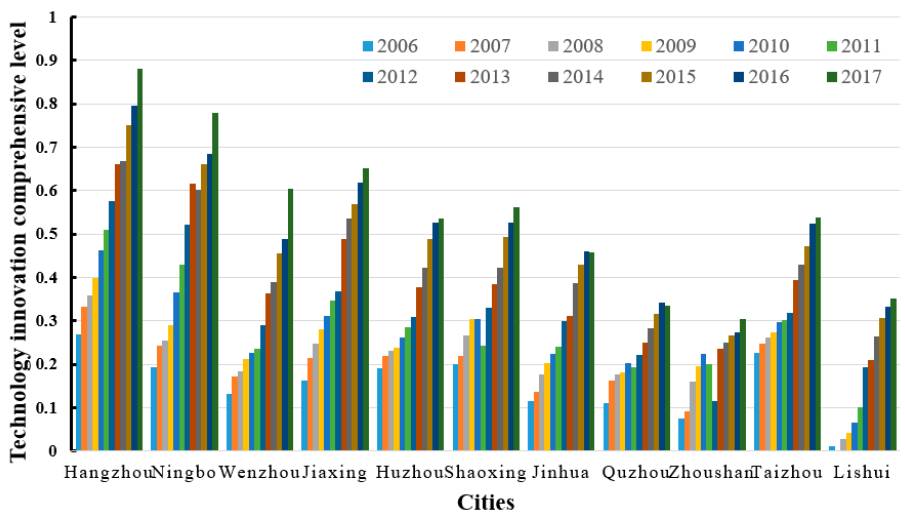
Figure 4. Trends in the technology innovation system scores of 11 cities in Zhejiang.